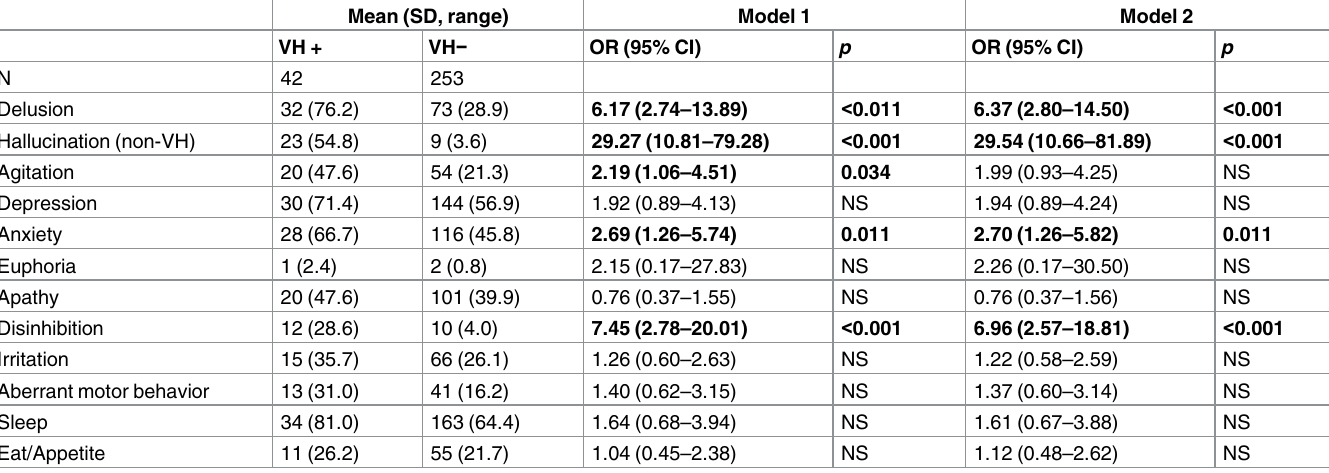
Table 3. Two models of risk estimates(odd ratios) for frequencies of neuropsychiatric symptoms in the NPI between the VH+ and VH − AD groups. Mean (SD, range) Model 1 Model